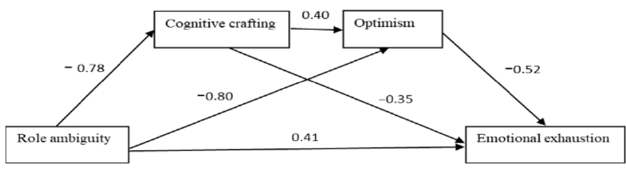
Figure 4. Paths values for the sequential mediation model 1.